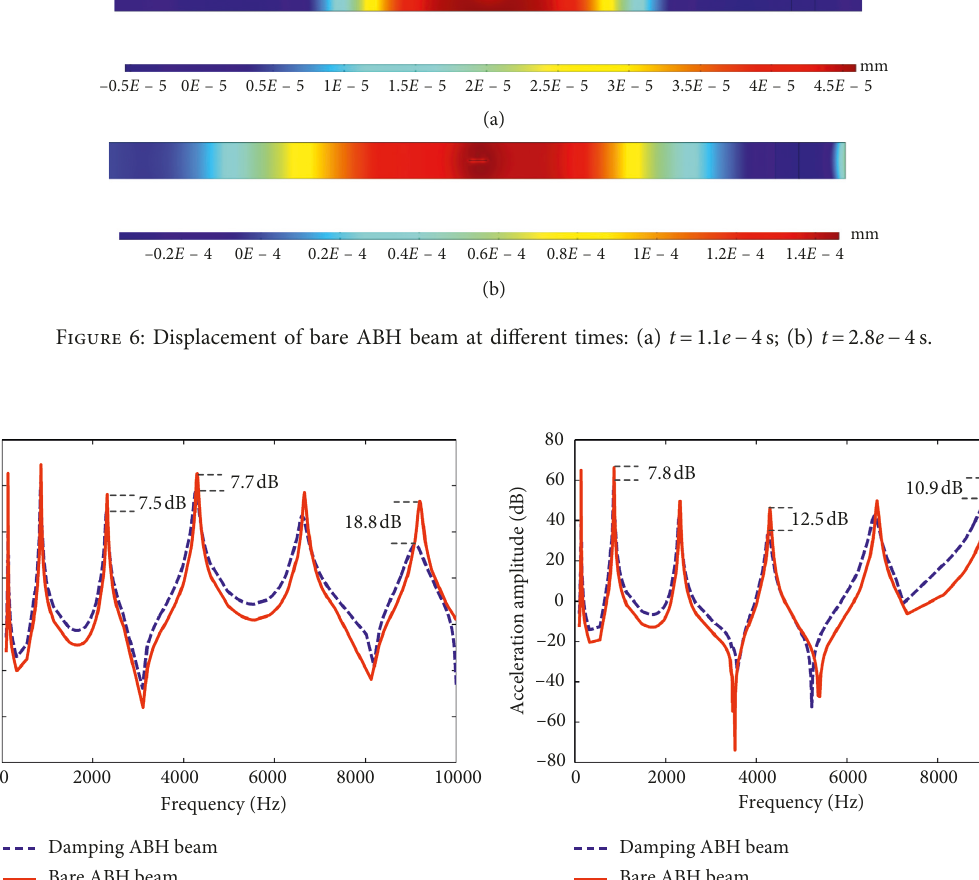
� 8 . 87 cm); (b) uniform beam region m